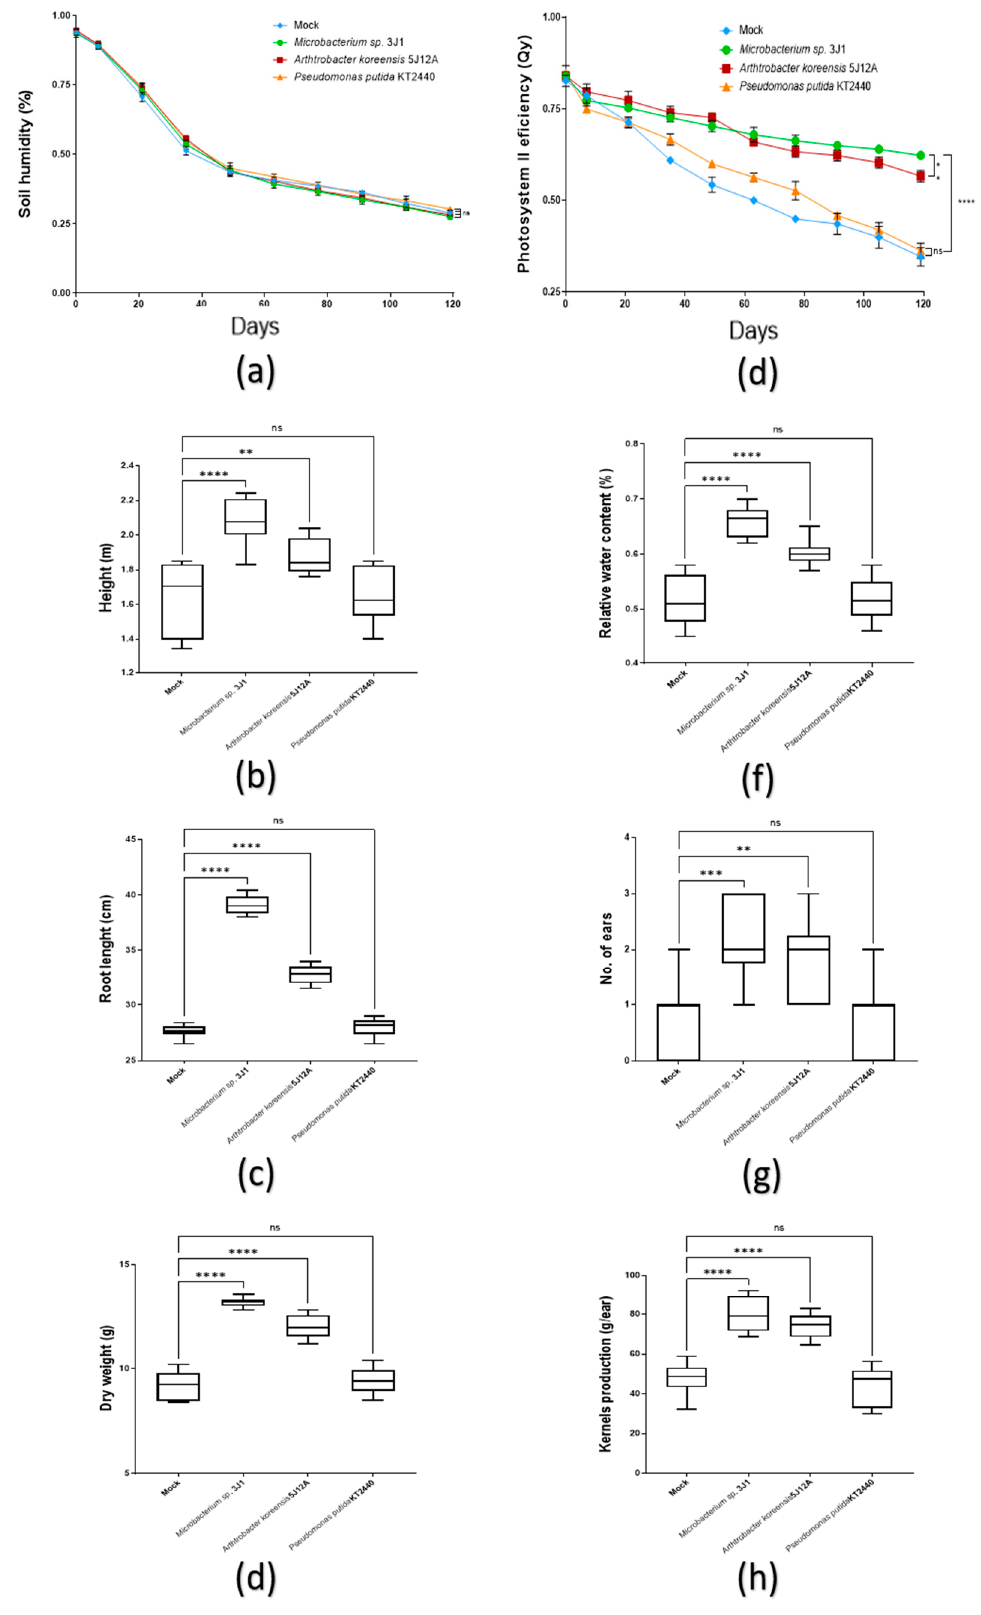
Figure 6. Evaluation of capsule treatment 120 DAT in maize plants under drought conditions. ( a ) The line graph shows soil humidity representative data from three independent experiments ( n = 9); ( b ) boxplot graphs record the height; ( c ) the root length; ( d ) and the dry weight biomass of the